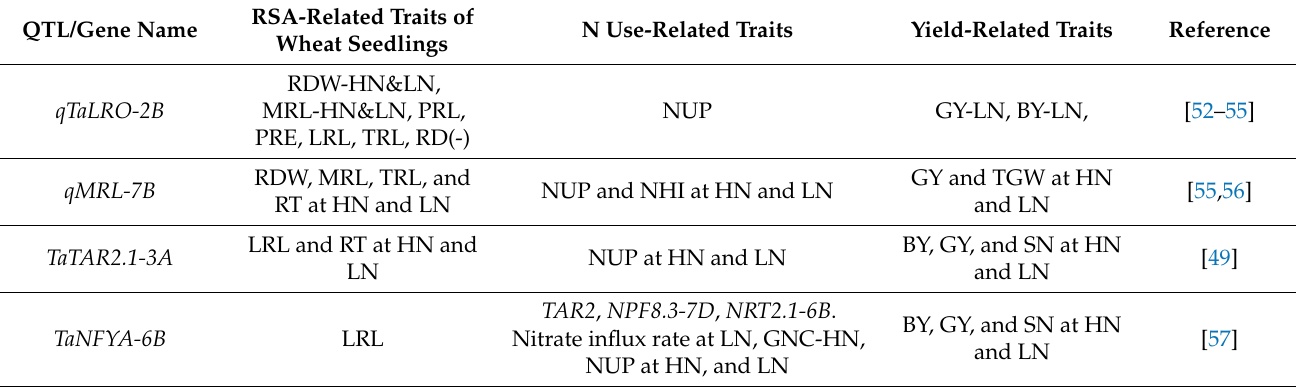
Table 3. QTL/genes controlling root system architecture (RSA)- and N uptake-related traits of wheat